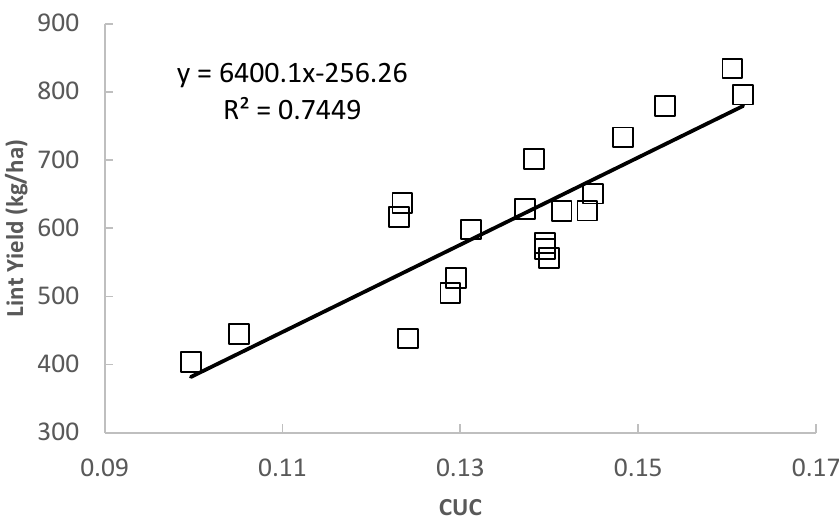
Figure 4. CUC quantification ( a ) LoG of UAV RGB images of individual small cotton boll; ( b ) LoG of UAV RGB images of large cotton boll/boll clusters; ( c ) thresholding of LoG of UAV RGB images of large cotton boll/boll clusters.